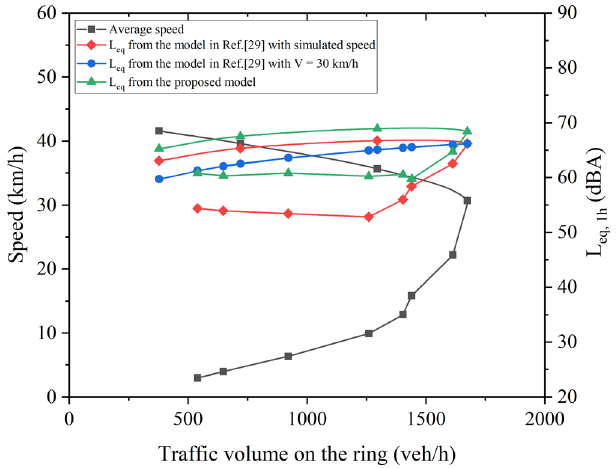
Figure 12. The relationship between the average speed and the traf fi c volume of the roundabout obtained by the proposed model and the relationship between L eq,1h at monitoring point P3 and the traf fi c